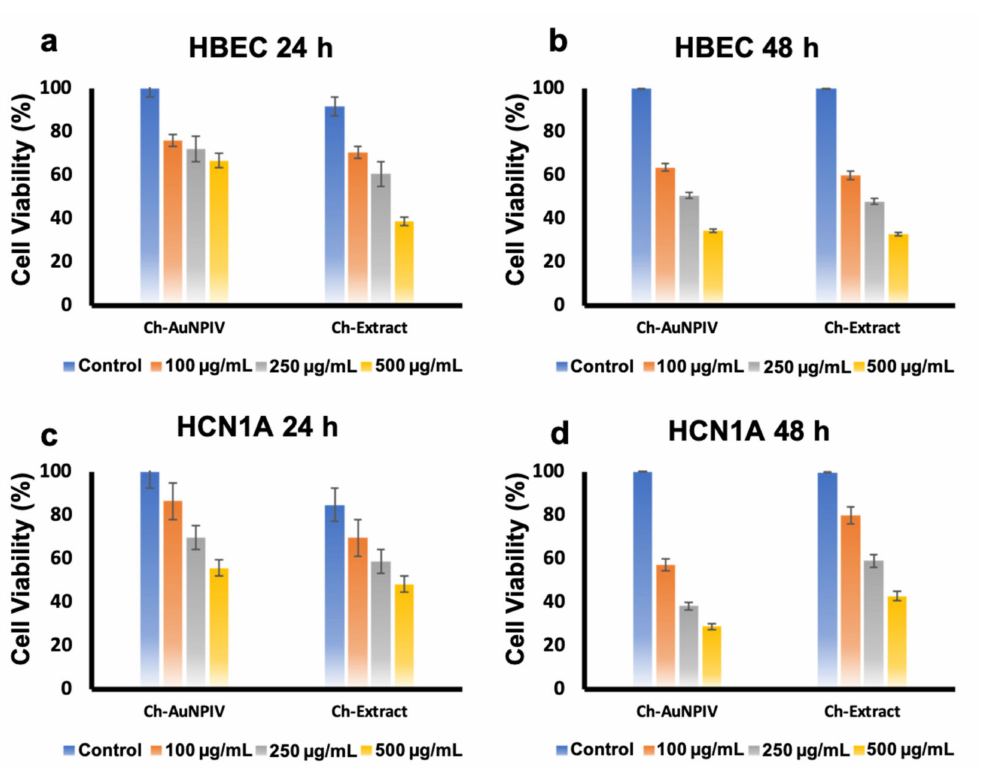
Figure 4. Cytocompatibility/toxicity analysis of the Ch-AuNPIV on normal brain cell lines. It could be observed that the NPs were clearly exerting toxicity to the cells ( a , c ), which was pronounced at 48 h observations ( b , d